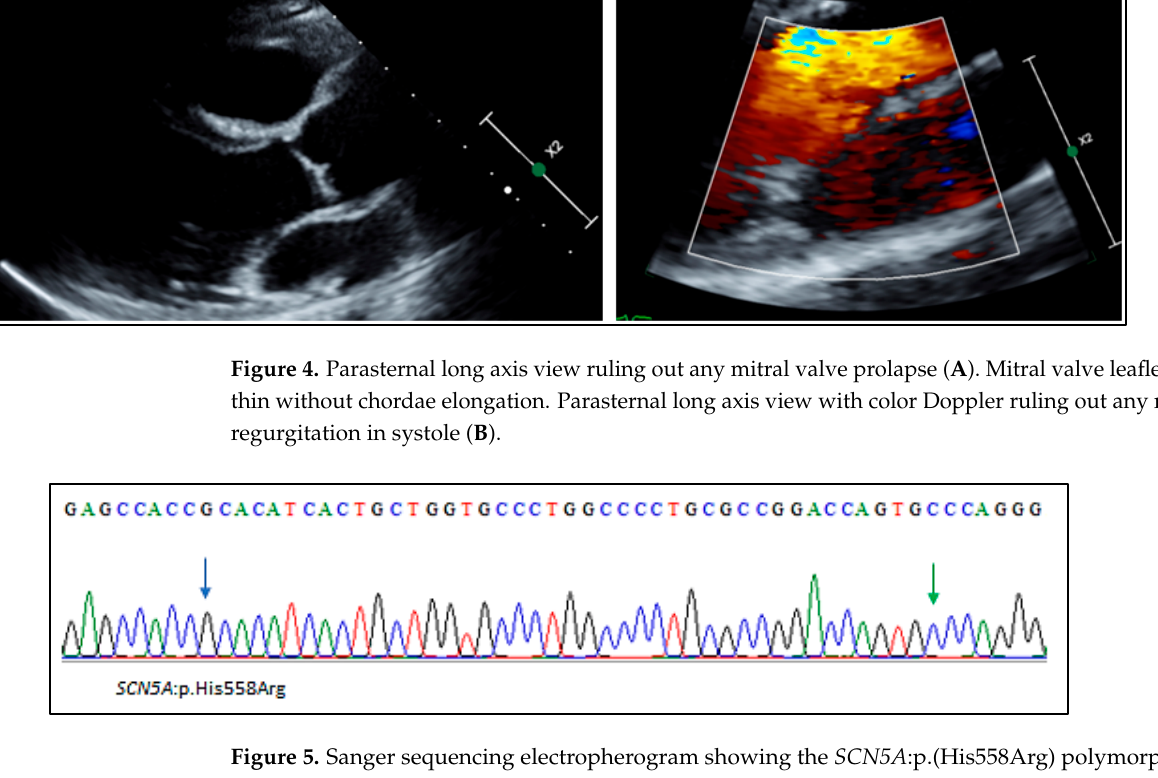
Figure 5. Sanger sequencing electropherogram showing the SCN5A : p.(His558Arg) polymorphism. The wild-type p.Ala572 residue is indicated by a green arrow.